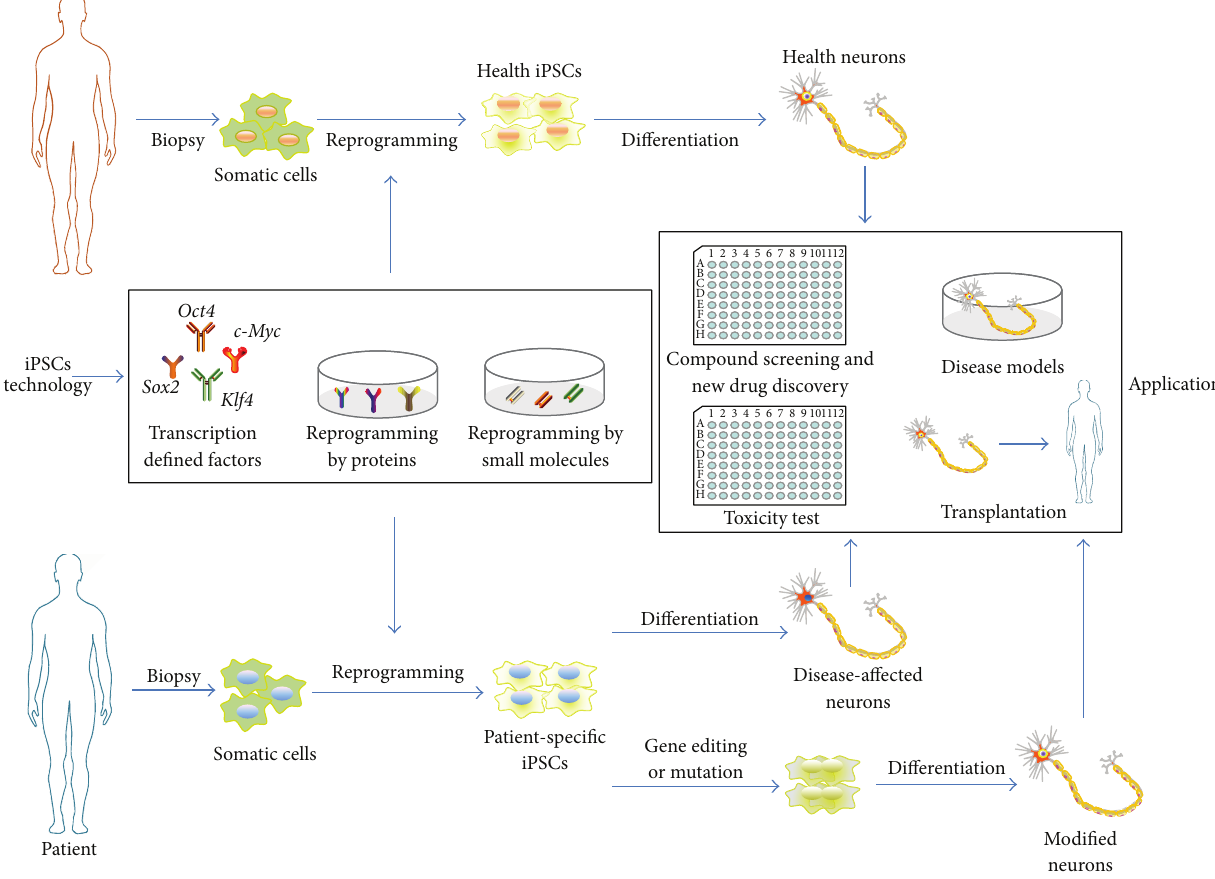
Figure 1: Basics of iPSC technology. Adult somatic cells can be reprogrammed into stem cell by the iPSC approach. iPSC-derived specific neurons can be used in drug screening and new drug discovery, toxicity tests, and models for studying the neurodegenerative diseases and for self-transplantation